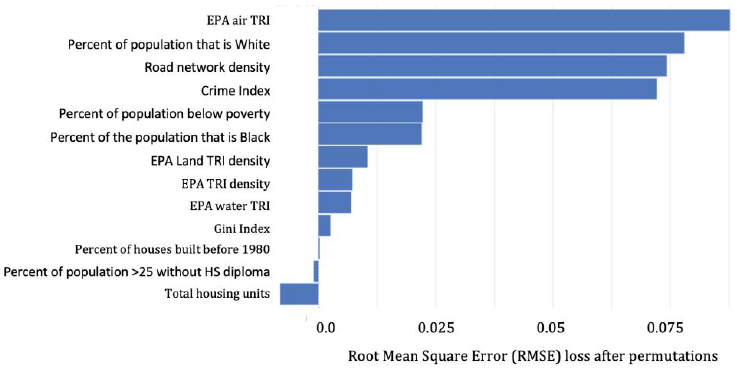
Figure 5. Predictor importance for ensemble learners predicting the number of children in a raster cell with BLLs ≥ 5 µg/dL.